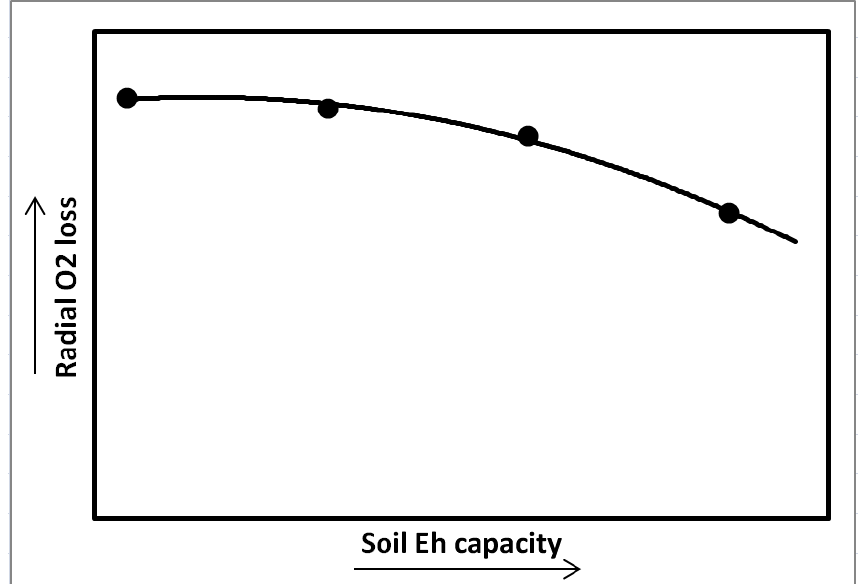
loss (ROL) in Spartina patens in response to changes in soil Figure 9. Radial O 2 reduction capacity while soil reduction intensity was maintained at (cid:237) 200 mV (Kludze and DeLaune